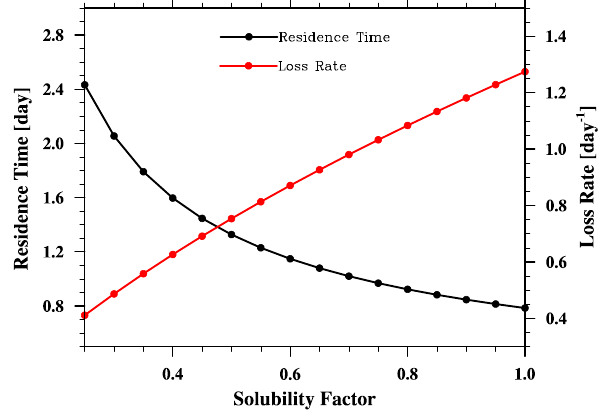
Fig. 5. The mass wet scavenging residence time and loss rate at solubility factors from 0.25 to